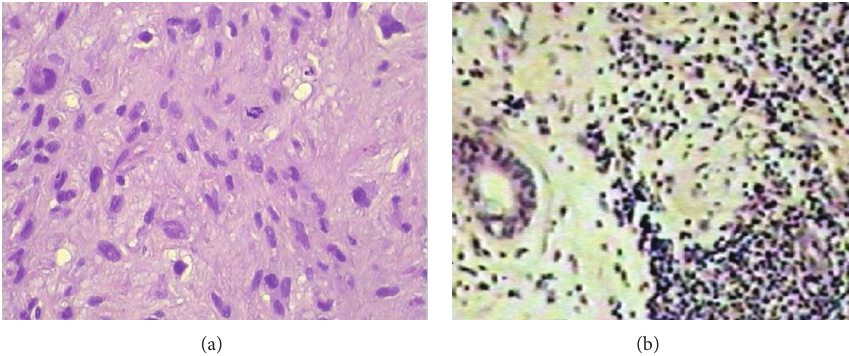
Figure 3: Photomicrograph of the histology. (a) The mass is made up of relatively hypo- and hypercellular areas. The cells are spindle or polyhedralshaped and show moderate degree of cellular pleomorphism and frequent mitoses (haematoxylin and eosin, original magnification × 100); (b) immunohistochemically the tumour cells stained strongly positive with monoclonal antibody vimentin (original magnification ×